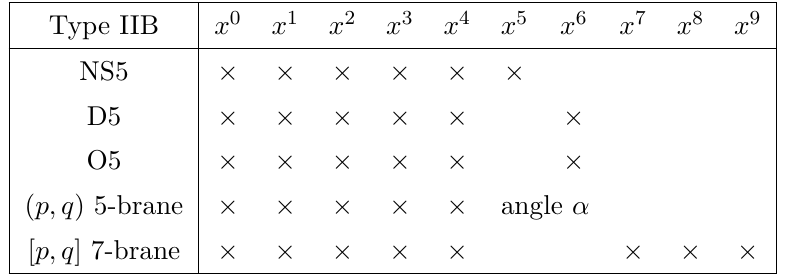
Table 5 . Type IIB 5-brane web set-up: indicates the space-time directions spanned by the (cid:2) various branes and the orientifold plane. A ( p; q ) 5-brane is a line of slope tan( (cid:11) ) = q(cid:28) 2 = ( p + q(cid:28) 1 ) in the x 5 ; 6 plane where the axiodilaton is (cid:28) = (cid:28) 1 + i(cid:28) 2 . In this paper all the brane webs are drawn for the value (cid:28) = i , so that tan( (cid:11) ) = q=p .